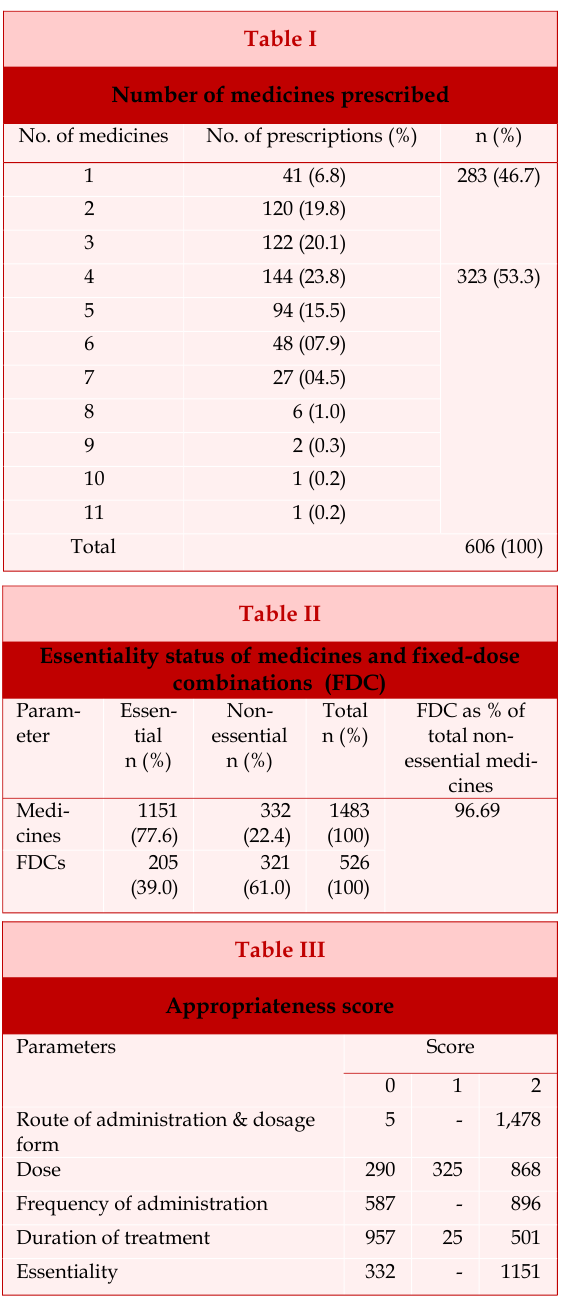
Appropriateness